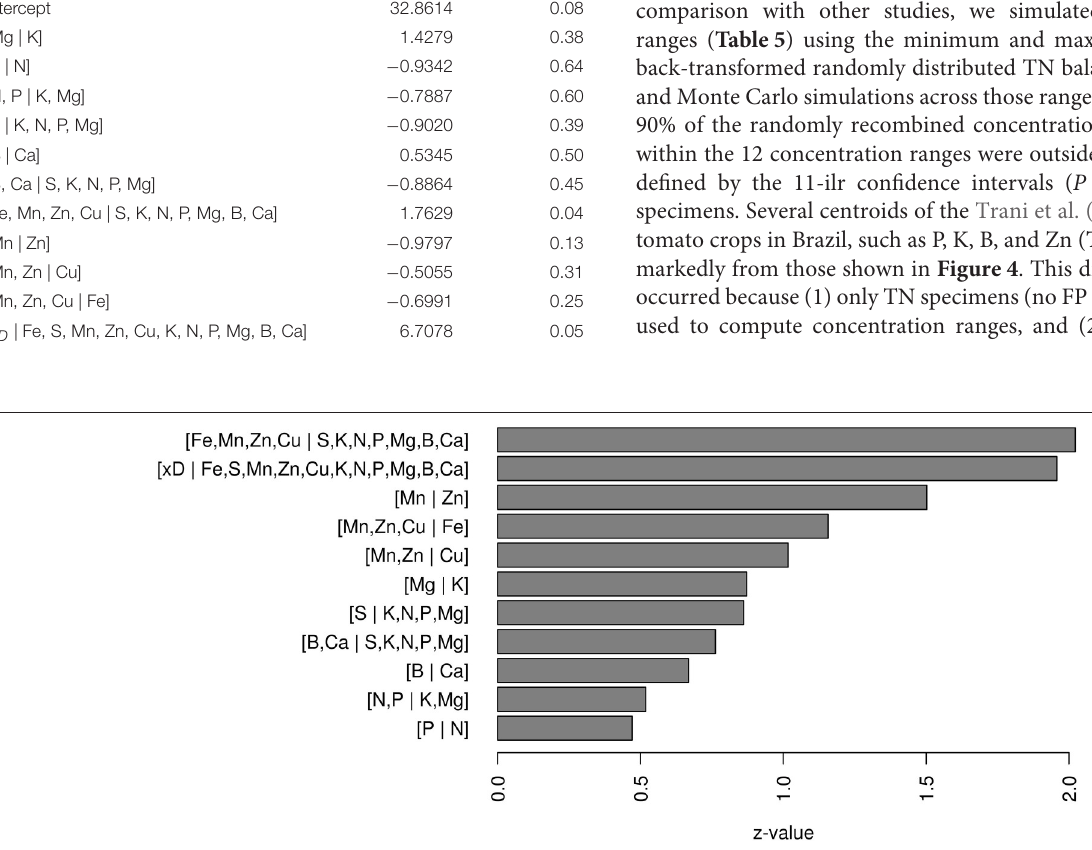
TABLE 5 | Coefficient of predictive binomial logit model elaborated from testing data set. Balance Coefficient p -value Intercept 32.8614 0.08